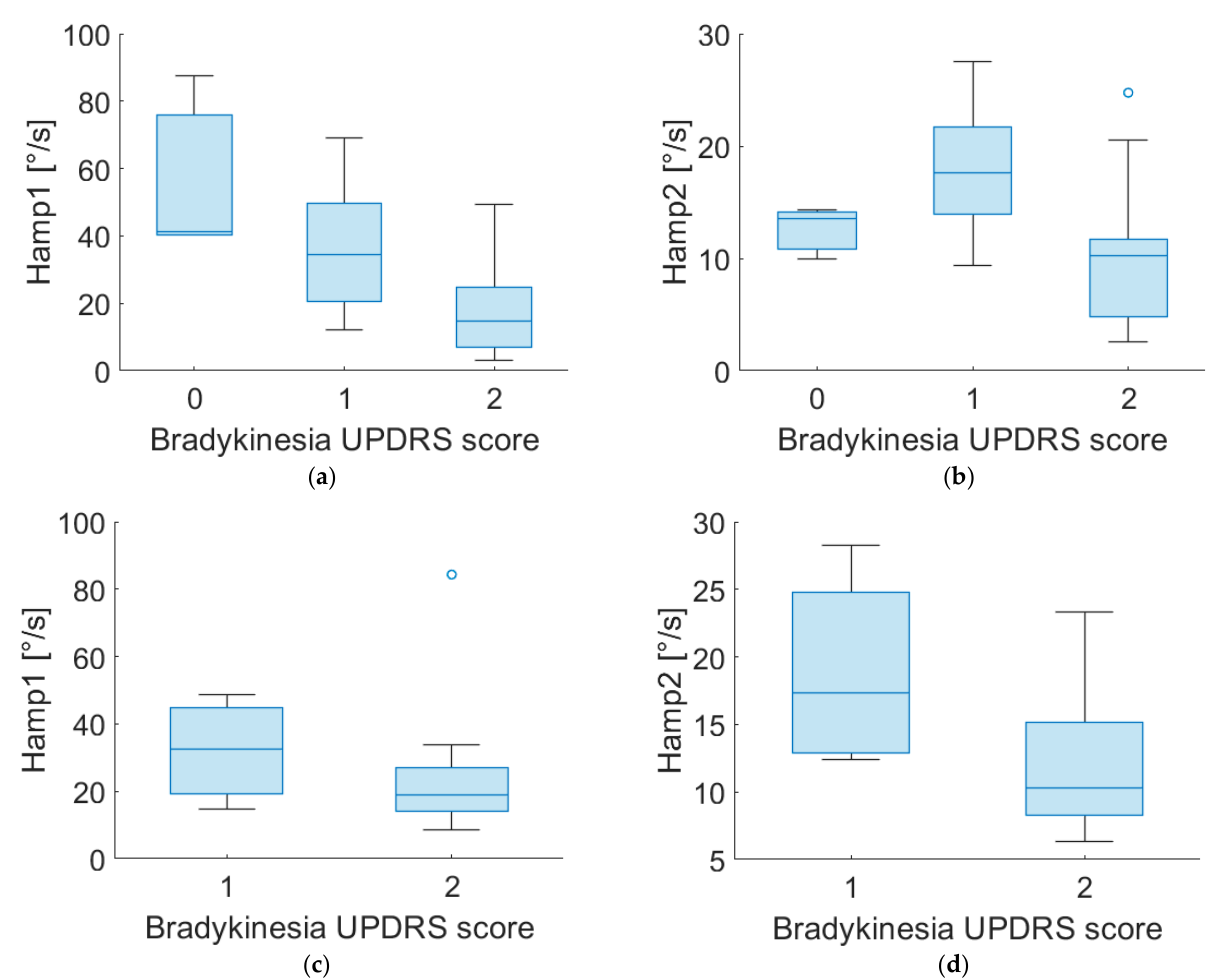
Figure 4. Boxplot of Hamp1 and Hamp2 of “most affected” side for PD-DN ( a , b ) and PD-OFF ( c , d ) subjects for different scores of UPDRS item no. 3.14 (bradykinesia).